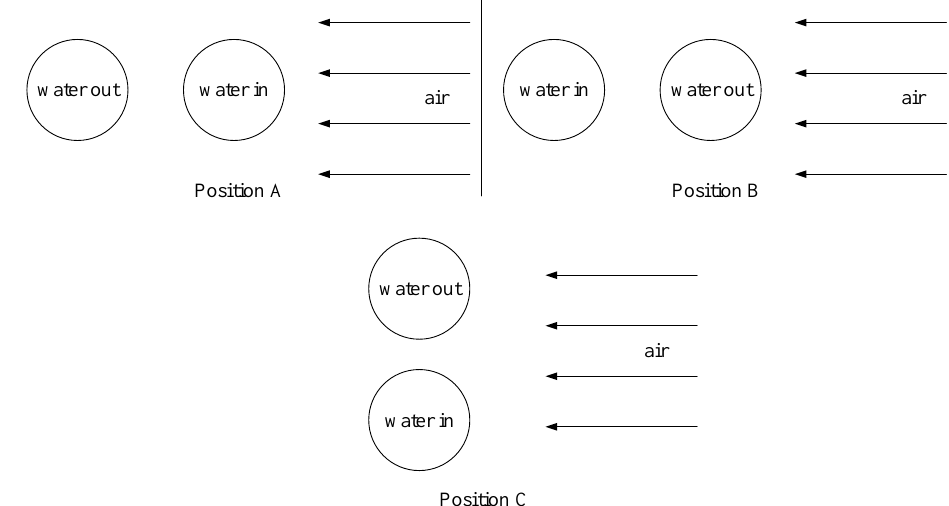
Figure 4. Orientation of heat exchanger relative to the air